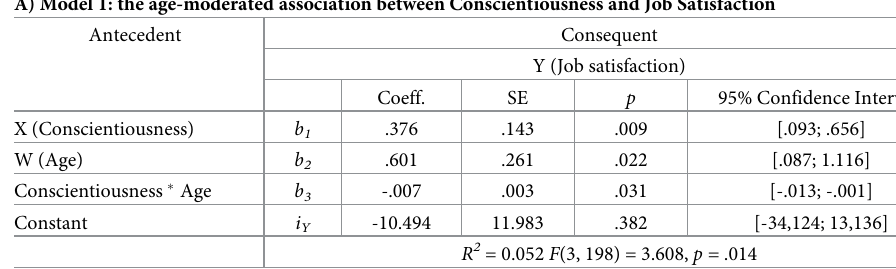
Table 2. Coefficients of the moderation